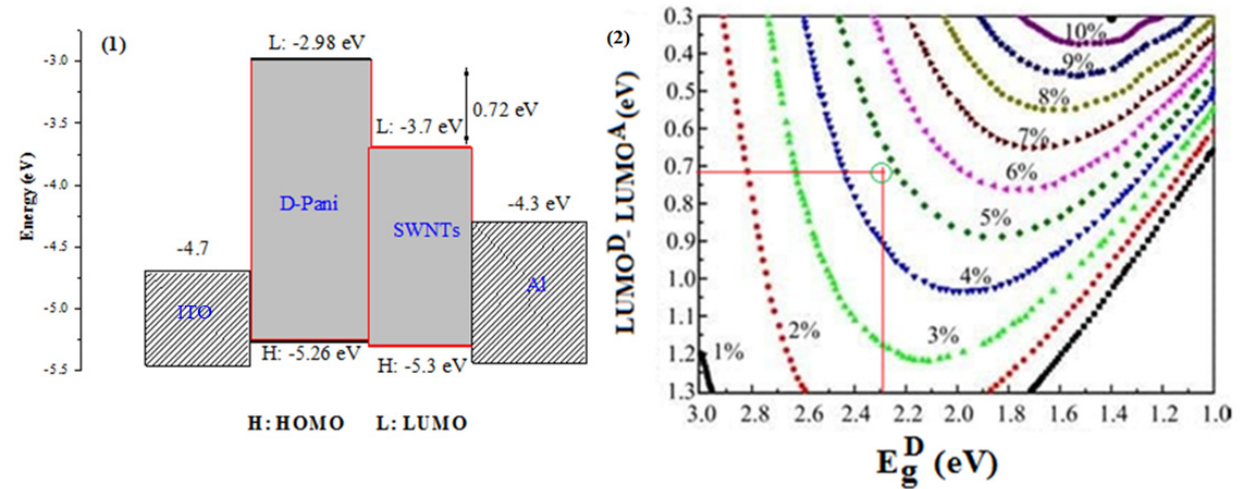
Figure 16. ( 1 ) Electrode choice for the photovoltaic device. ( 2 ) Estimation of PCE from the Scharber diagram [19].